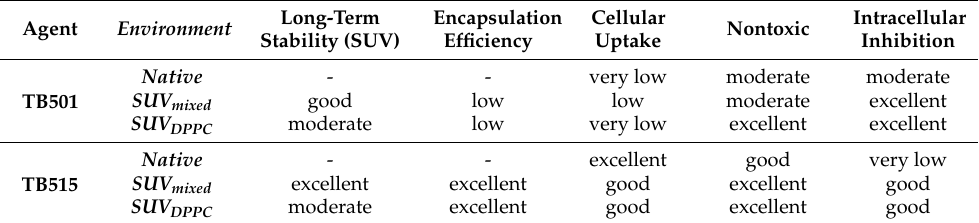
Table 6. Summarized evaluation of antitubercular agent candidates (TB501 and TB515) from several aspects in native and in the two liposome-encapsulated (SUV mixed and SUV DPPC )